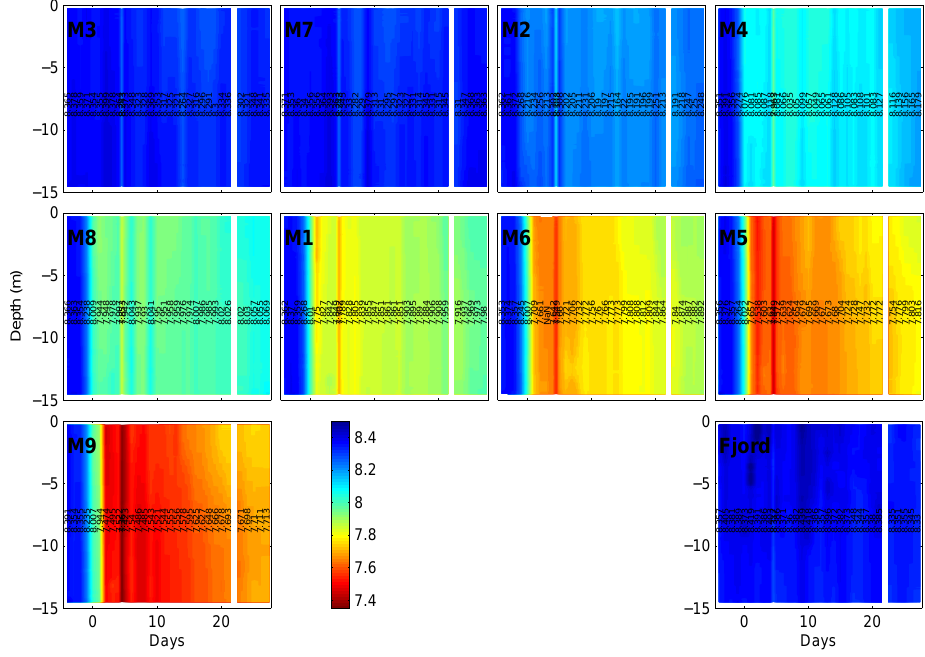
Fig. 3. Temporal pH dynamics in each mesocosm and the fjord. Vertical profiles were taken daily by means of a hand-operated CTD. Recorded pH values were corrected by calculated pH from measured dissolved inorganic carbon and total alkalinity and are reported on the total scale. Black numbers denote daily depth-averaged (0.3–12m) mean pH values. See Sect. 2 for further